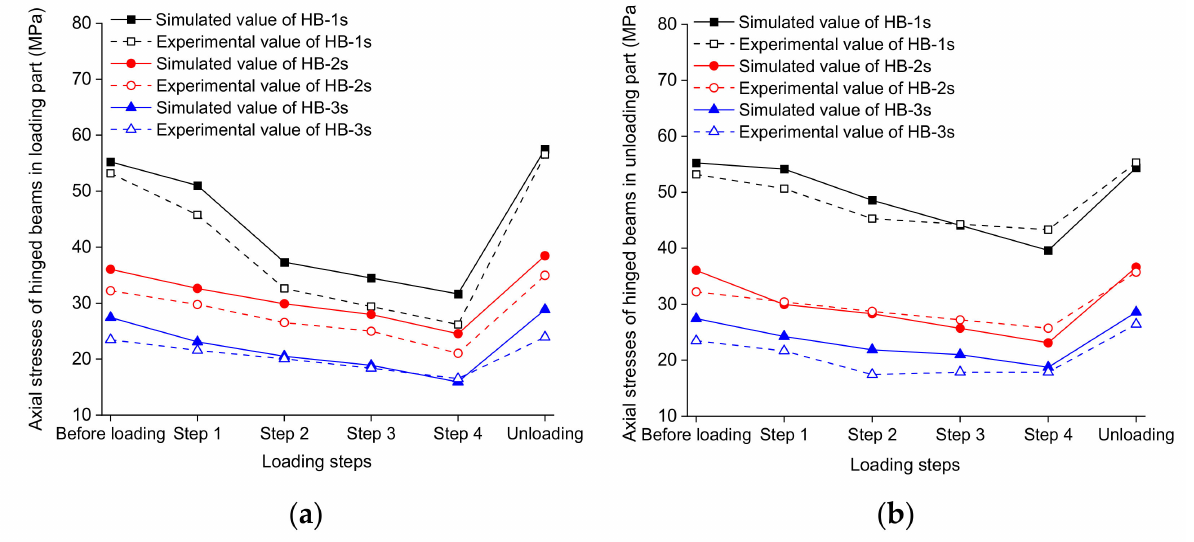
Figure 28. Axial stresses of the HBs for the half-span static loading test. ( a ) Loading part; ( b ) Unloading part.